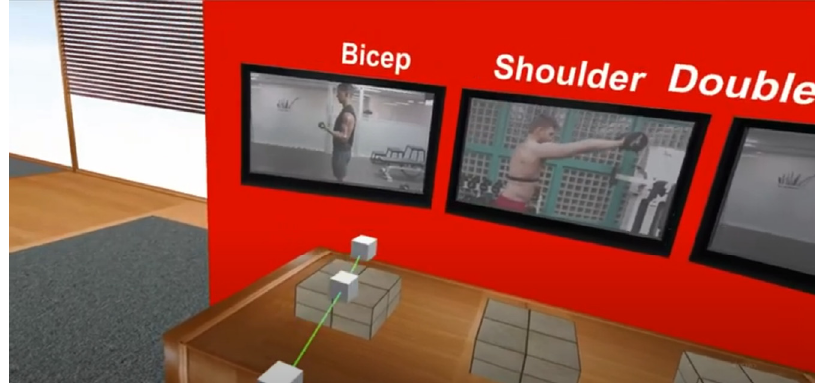
Figure 9. Proposed three exercise scenarios: dumbbell (bicep), shoulder, and barbell curl.